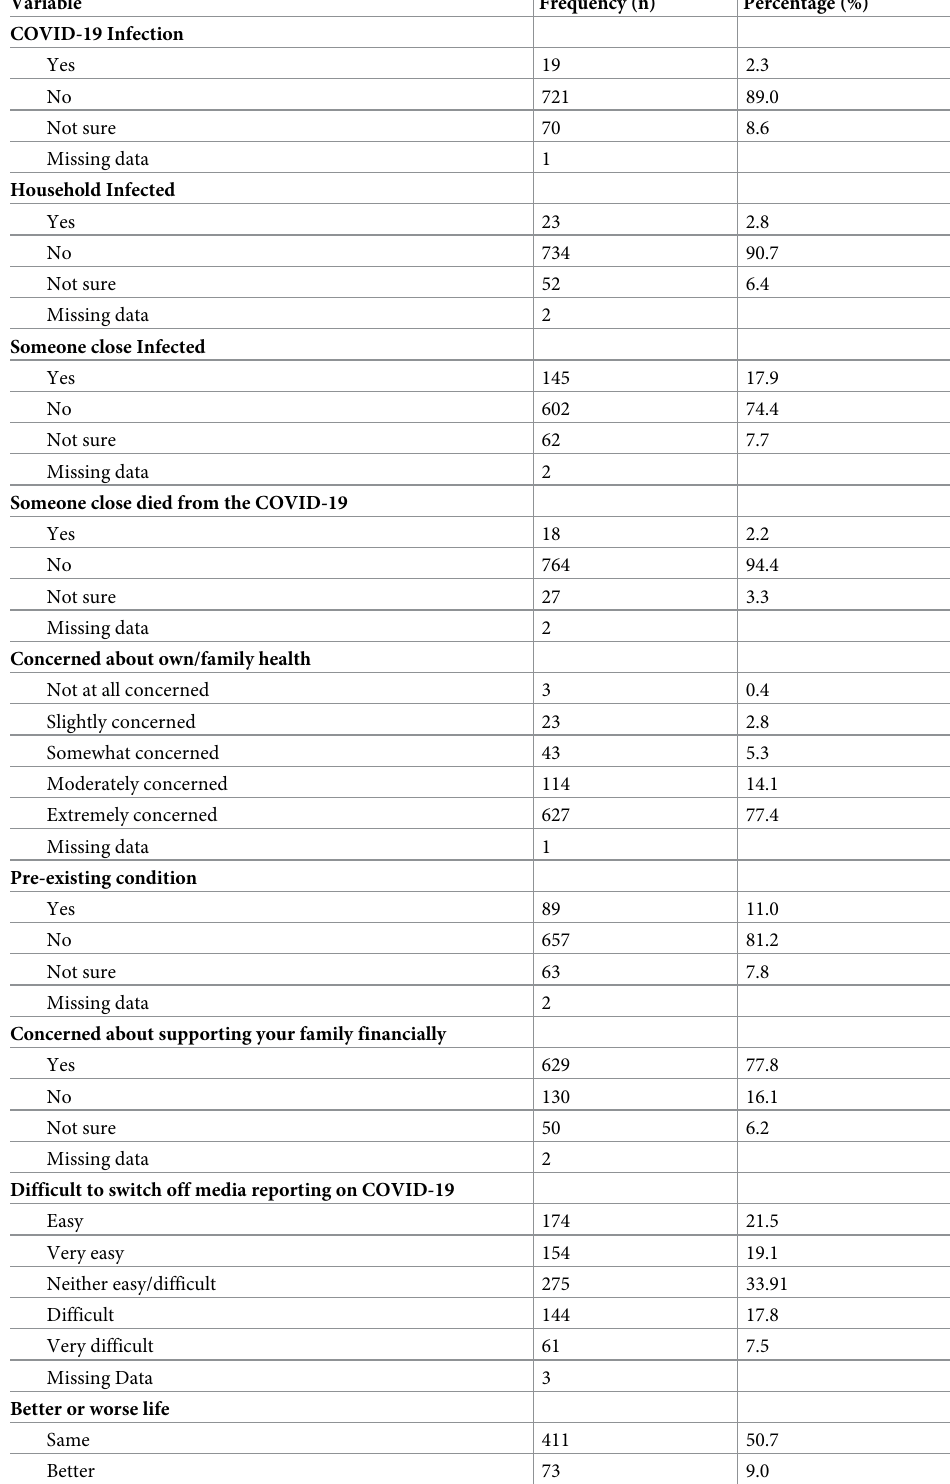
Table 2. COVID-19 related characteristics of participants (N =